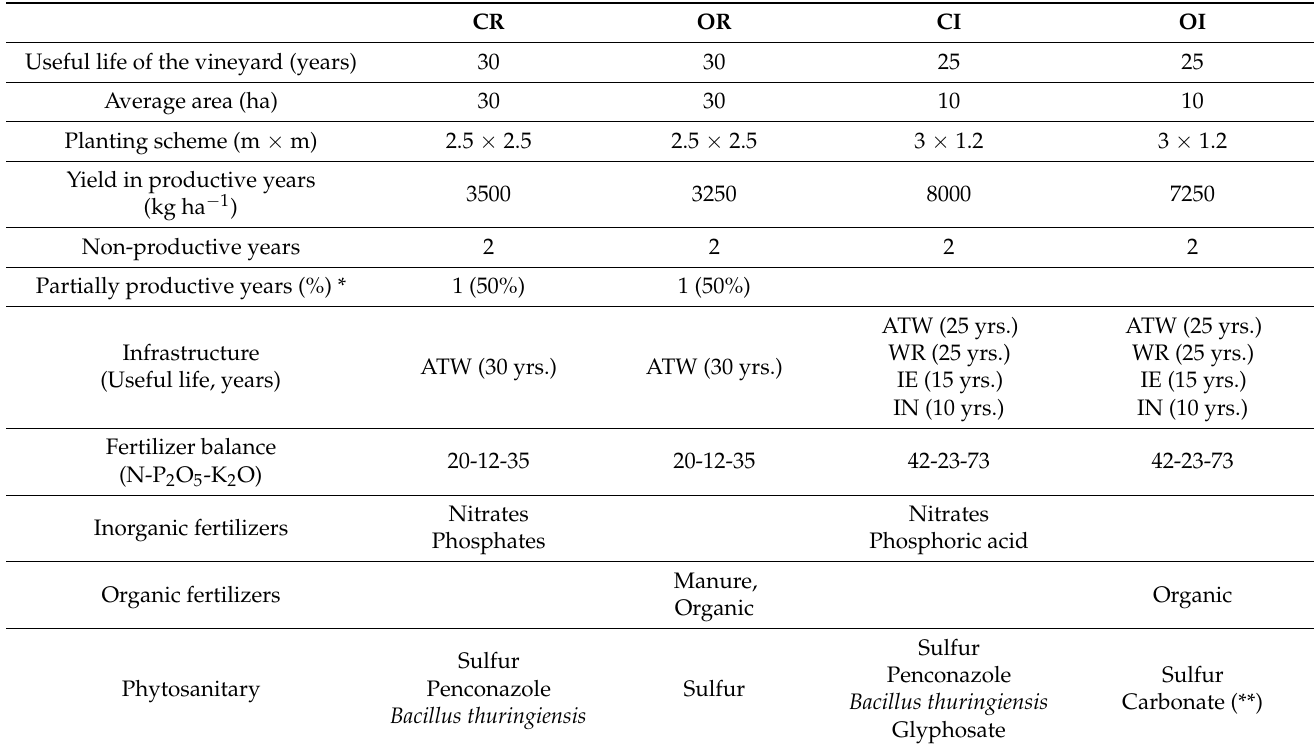
Table 1. General characteristics of the four vineyard models. CR: conventional rainfed; OR: organic rainfed; CI: conventional irrigation; OI: organic irrigation. CR OR CI